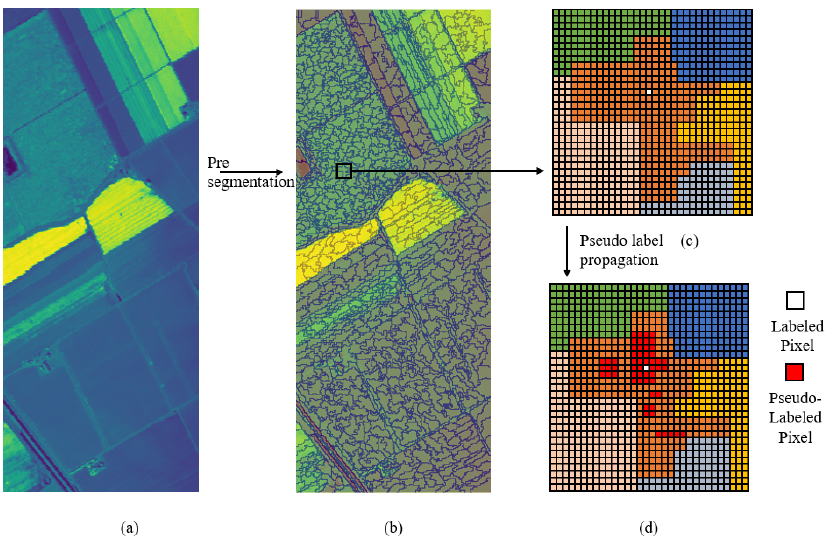
Figure 5. The pseudo-label propagation of HSI data. ( a ) is the HSI after the dimension reduction algorithm (e.g., PCA). ( b ) is the image pre-classification by TFNet. Different colored regions represent the different score areas on the table. ( c ) is the small portions of the hyperspectral image after pre- classification. In ( d ), the increased number of red squares indicates the pseudo-label is the same as the original label propagation in the pre-segmentation